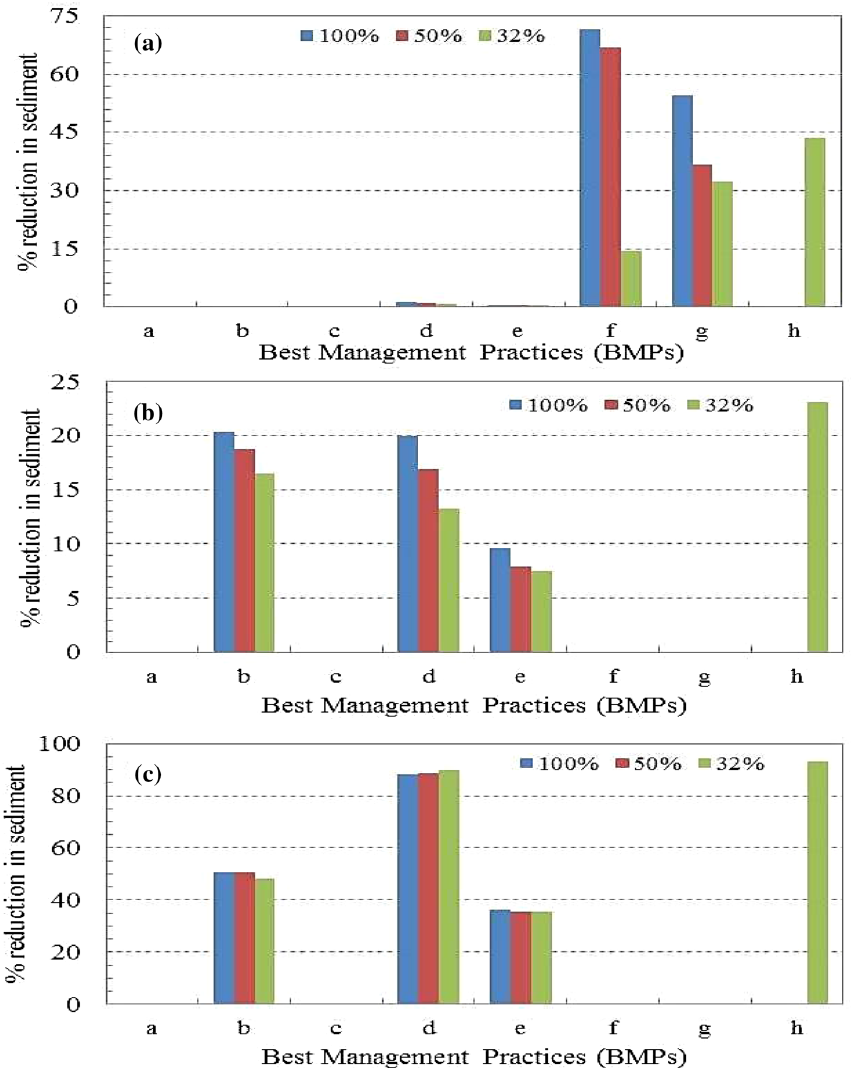
Fig. 8 Sediment declination in percent for various percentage of varied-crop region treated a at watershed level, b at sub- watershed level and c at HRS